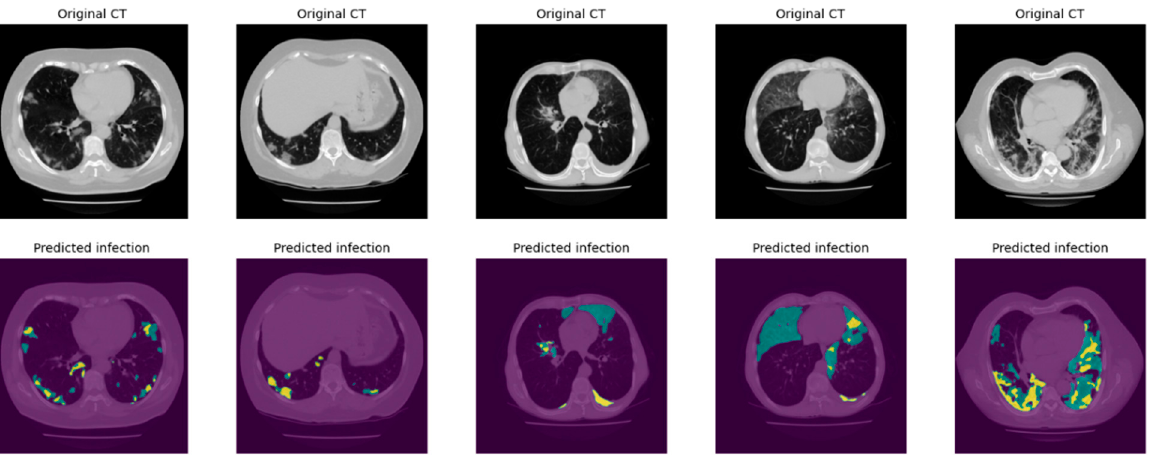
Figure 8. Patch segmentation results. The green area represents the GGO and Crazy Paved pattern. The yellow area shows the Consolidation area.